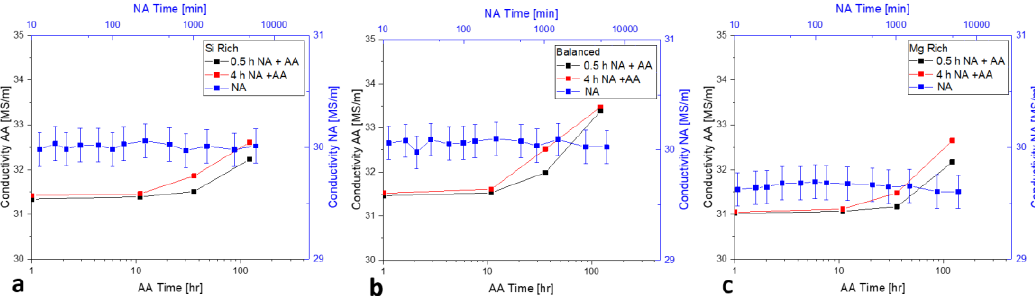
Figure 12. Low strength alloy AA hardness evolution after AC and WQ, for both prior NA conditions (labelled accordingly). WQ results are included, and plotted semi-transparently, for comparative purposes. Error bars represent 95% confidence.